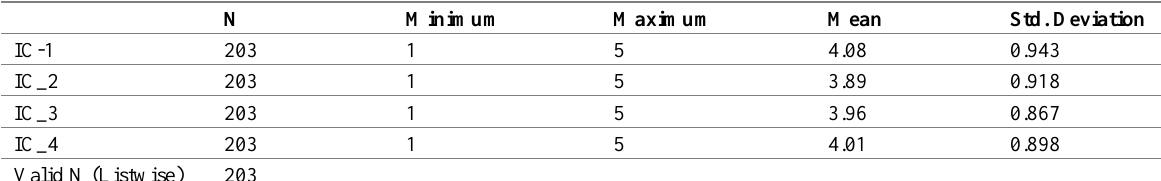
Table 7: Individualized Consideration